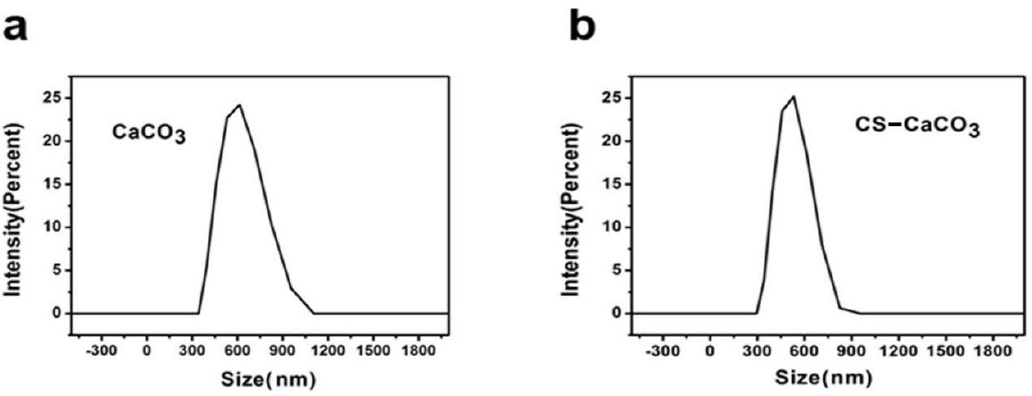
Figure 2. DLS results of ( a ) CaCO 3 and ( b ) CS – CaCO 3 . Presence of CaCO 3 and CS – CaCO 3 in the novel material was further illustrated by FTIR. FTIR data of the developed CS – CaCO 3 composite material (Figure 3a) showed the characteristics peaks of CaCO 3 at 713, 877, and 1427 cm −1 (−CO 3 stretching) and character- istics peaks of Chitosan at 1070 (−C−O stretch), 1425, 1566 (−N−H stretch) and 2920 cm −1 (−C−H stretch) , which indicated the presence of CaCO 3 in the CS – CaCO 3 composite mate- rials.